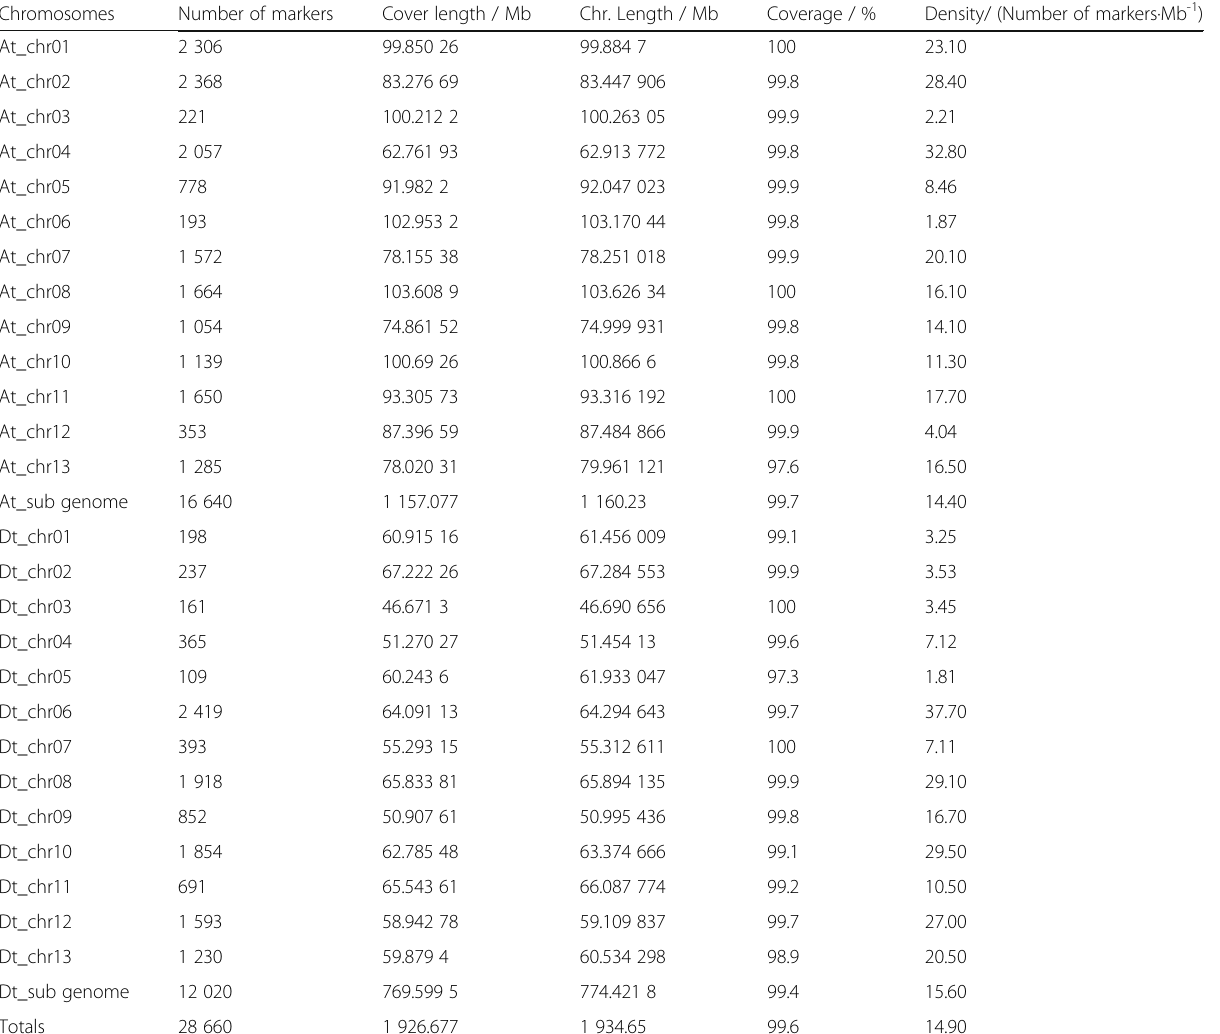
Table 2 The GBS marker numbers per linkage group and their coverage on the 26 chromosomes of the AD cotton genome Chromosomes Number of